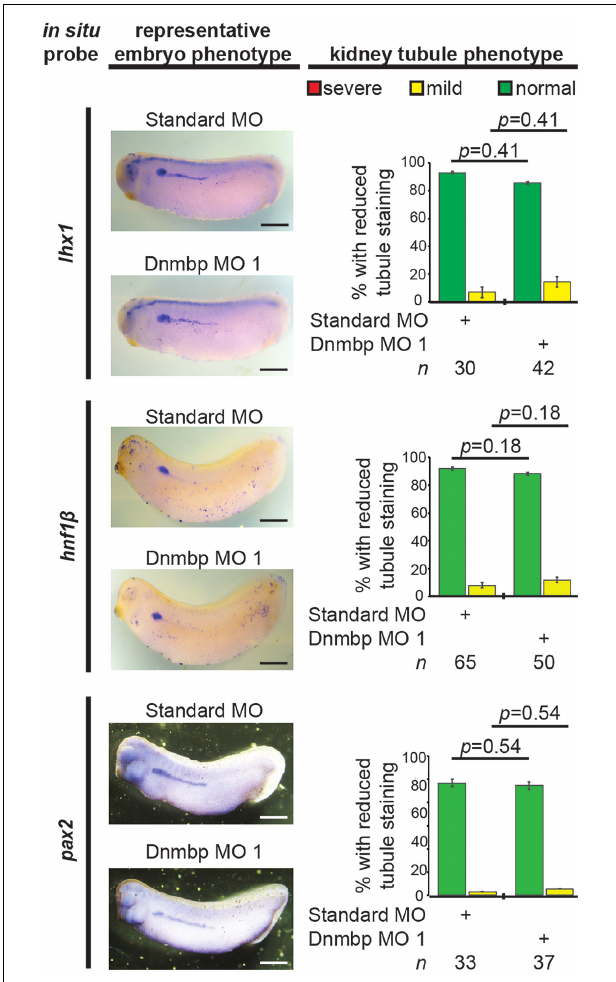
FIGURE 8 | Dnmbp knockdown does not alter expression of early markers of kidney development, as assessed by in situ analysis. Embryos injected unilaterally at the 8-cell stage (blastomere V2) to target the kidney and reared to stage 29–30 for lhx1 expression assessment, stage 32–33 for hnf1 β expression assessment and stage 33–34 for pax2 expression assessment. Representative embryo phenotypes shown. Scale bar indicates 500 µ m. n = number of embryos across 2 ( pax2 ) or 3 replications ( lhx1 , hnf1 β ). Error bars represent Standard error. ∗ Significantly different from control, p < 0.05.